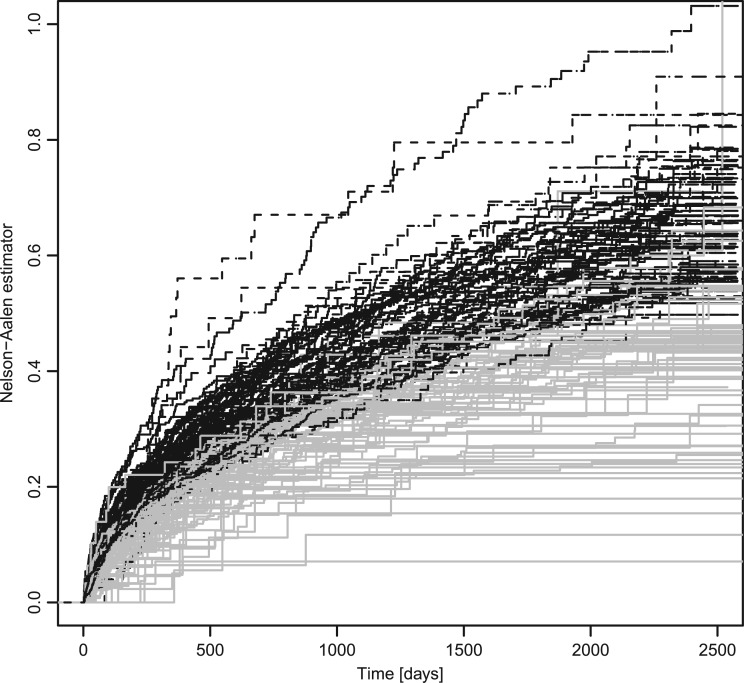

\documentclass[12pt]{minimal}
\usepackage{amsmath}
\usepackage{wasysym}
\usepackage{amsfonts}
\usepackage{amssymb}
\usepackage{amsbsy}
\usepackage{upgreek}
\usepackage{mathrsfs}
\setlength{\oddsidemargin}{-69pt}
\begin{document}
}{}$138$\end{document} structure-specific Nelson–Aalen curves drawn according to the membership of two latent populations from the frailty model for time to readmission. The gray curves are related to latent population 1, while the black dashed curves are related to latent population 2.